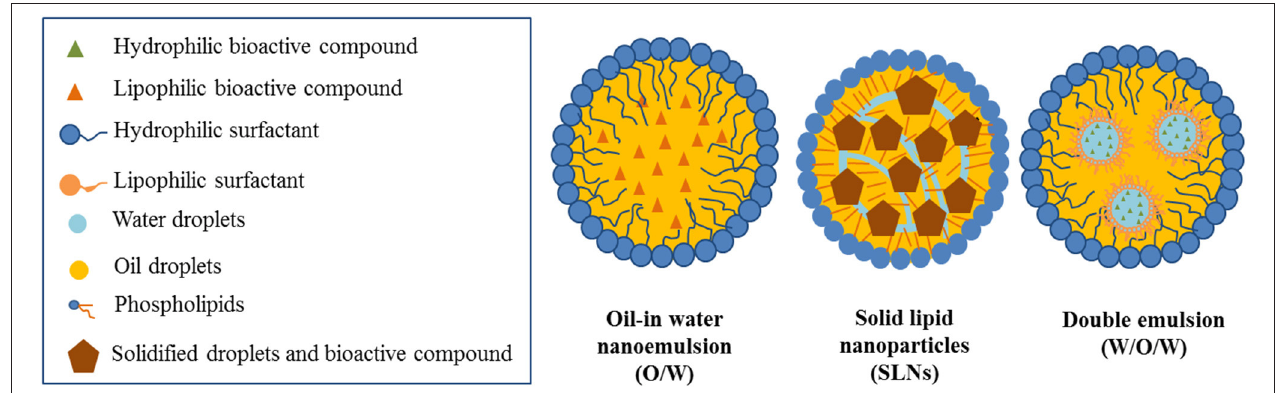
FIGURE 1 | Emulsion-based nanostructured systems as potential carriers of active ingredients in food systems.